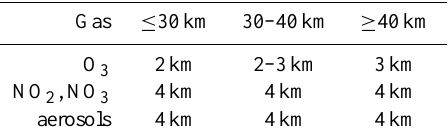
Table 2. Resolution of the GOMOS profile products.